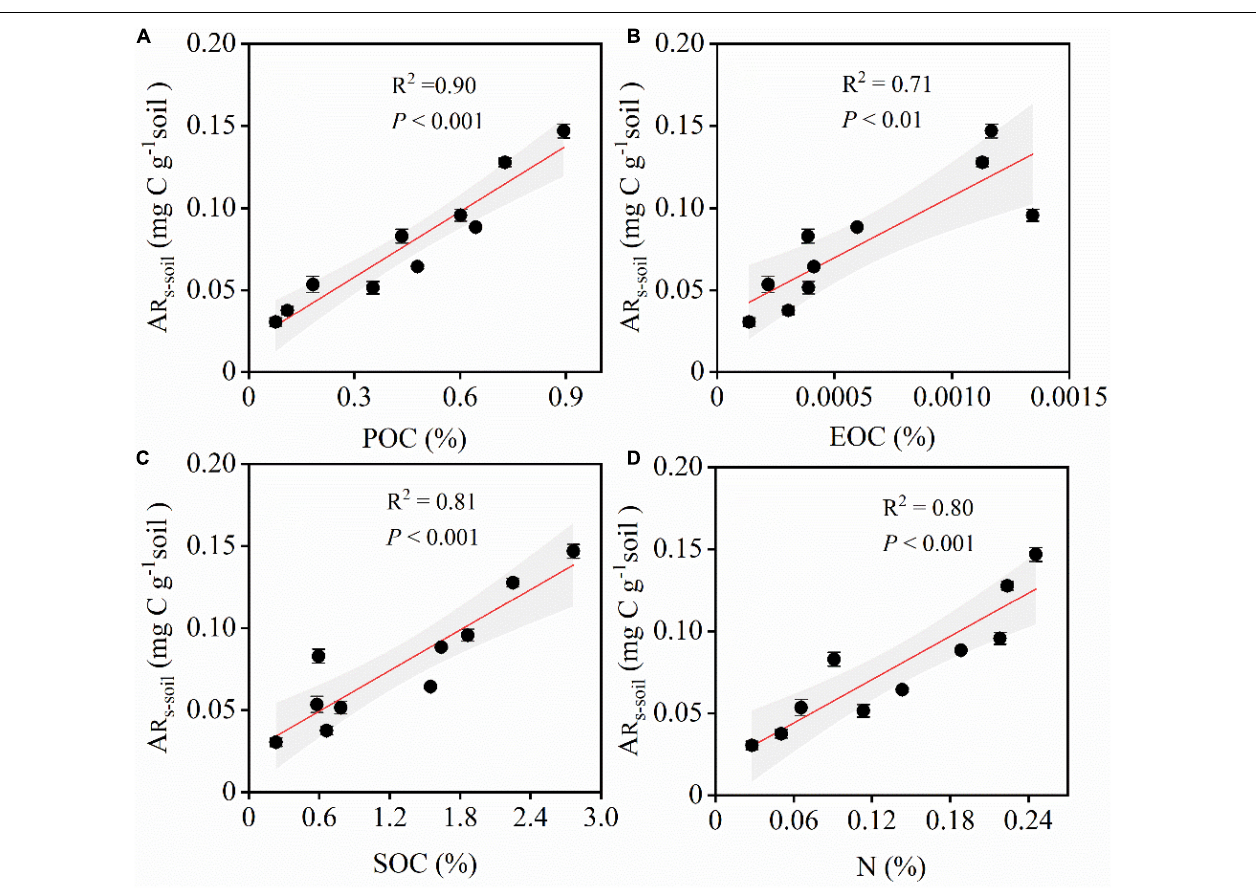
FIGURE 6 | Relationships between A Rs − soil and environmental factors. A Rs − soil , accumulative emission of CO 2 relative to soil (A) Relationships between A Rs − soil and POC. POC, particulate organic carbon. (B) Relationships between A Rs − soil and EOC. EOC, easily oxidizable organic carbon. (C) Relationships between A Rs − soil and SOC. SOC, soil organic carbon. (D) Relationships between A Rs − soil and N. N, total nitrogen. Shaded areas indicate the 95% confidence interval and vertical bars denote